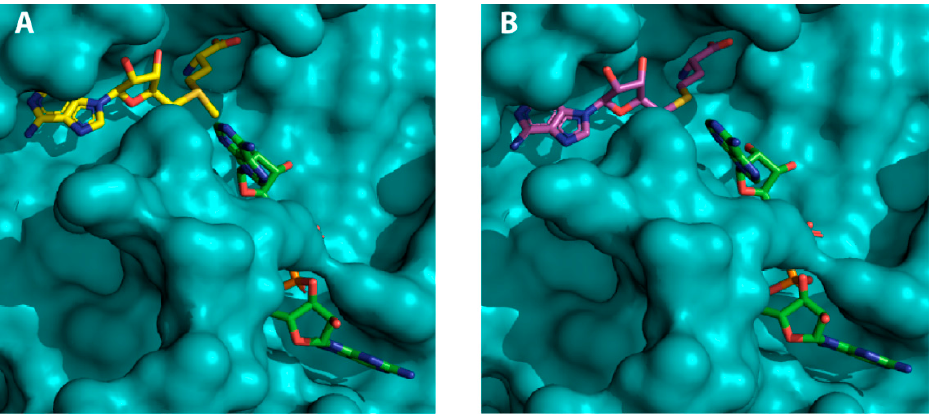
Figure 4. SAM-dependent methyltransferases (MTases) ligands and RNA in complex with SARS-CoV-2 NSP16: ( A ) surface representation of the NSP16 (teal), SAM (yellow) and RNA (green) ternary complex; and ( B ) surface representation of NSP16 (teal), SAH (magenta) and RNA (green) ternary complex.